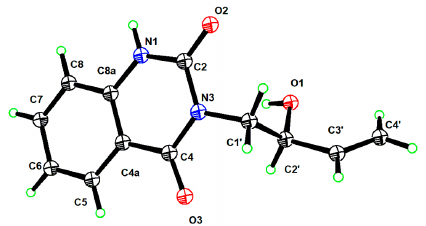
Figure 5. ORTEP darning of (+)-(2 ′ S )-isatisindigoticanine C ( 2b ).